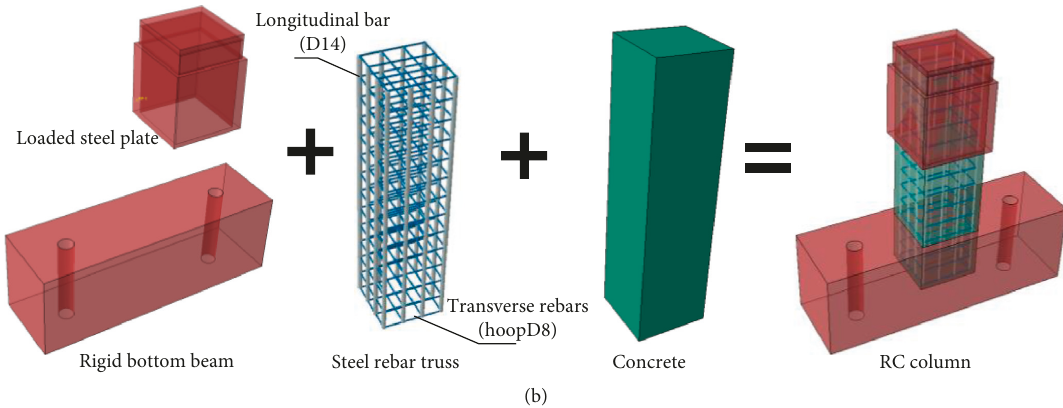
Figure 15: Finite element models of hysteretic analysis. (a) ISSCC column. (b) RC column.